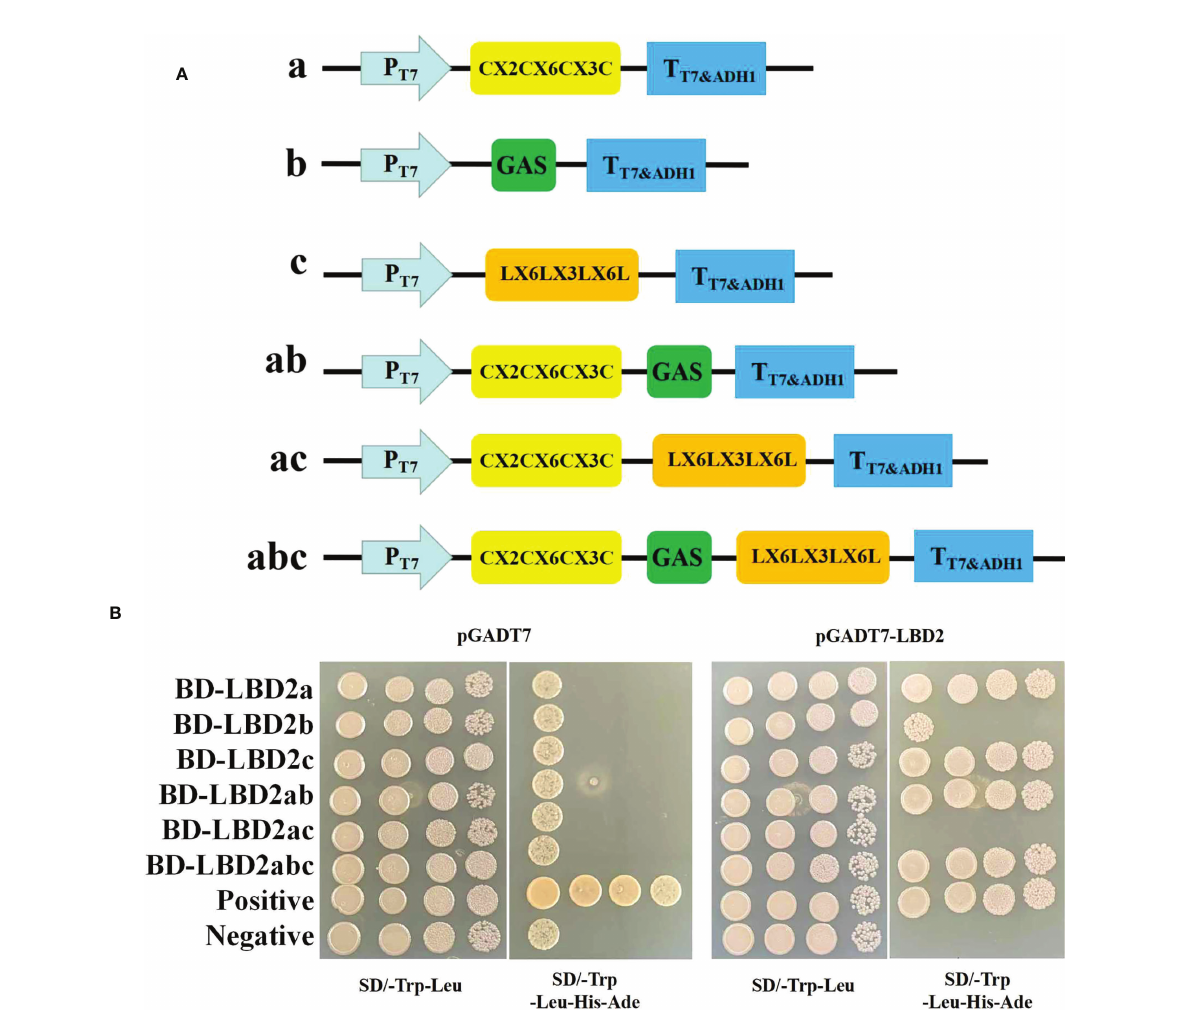
FIGURE 5 Analysis of the dimer-forming ability of ZmLBD2. (A) Strategy for yeast two-hybrid vector construction of the maize ZmLBD2 sequence. (B) The ability of ZmLBD2 to form dimers in the yeast strain Y2H Gold. The Y2H Gold strains containing target plasmids were diluted and cultured on SD/-Trp-Leu media or SD/-Trp-Leu-His-Ade media. Fragments a, b, and c represent CX2CX6CX3C, GAS, and